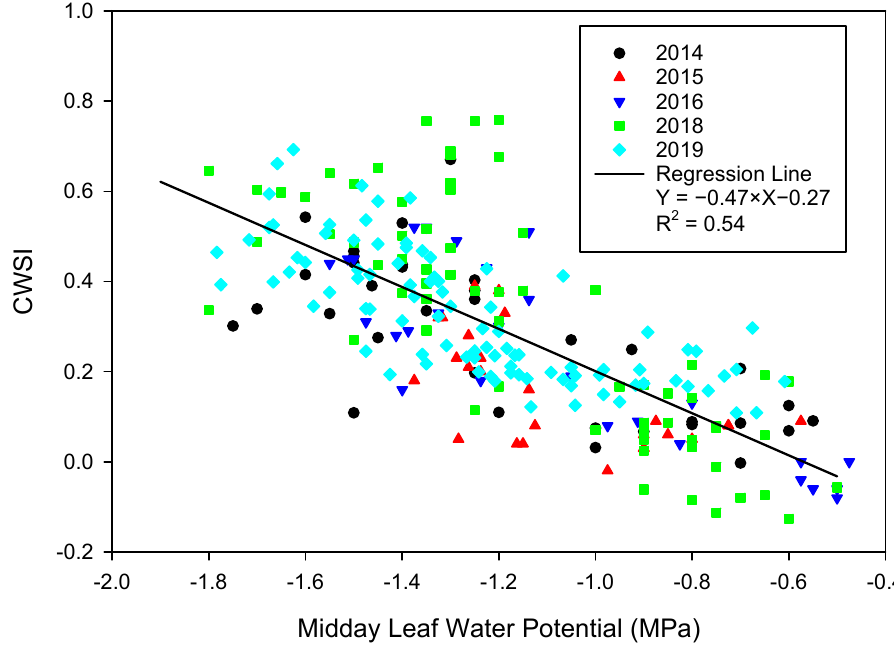
Figure 4. Linear relationship between the crop water stress index ( CWSI ) and midday leaf water potential of Malbec for the 5-year study at the experimental site.